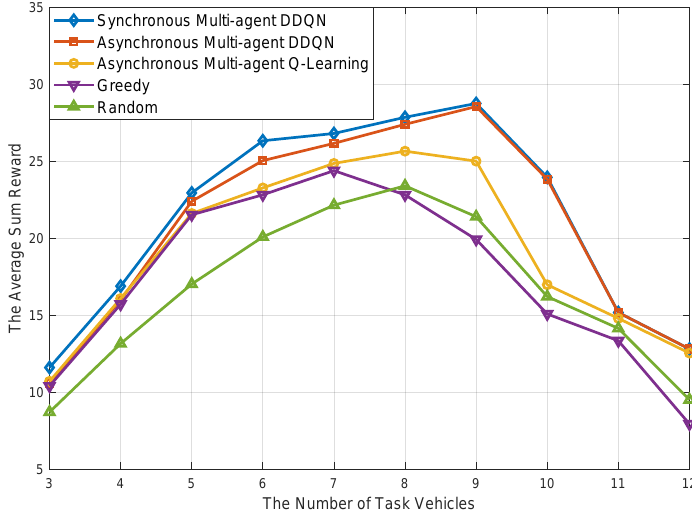
Figure 8. The performance of the overall